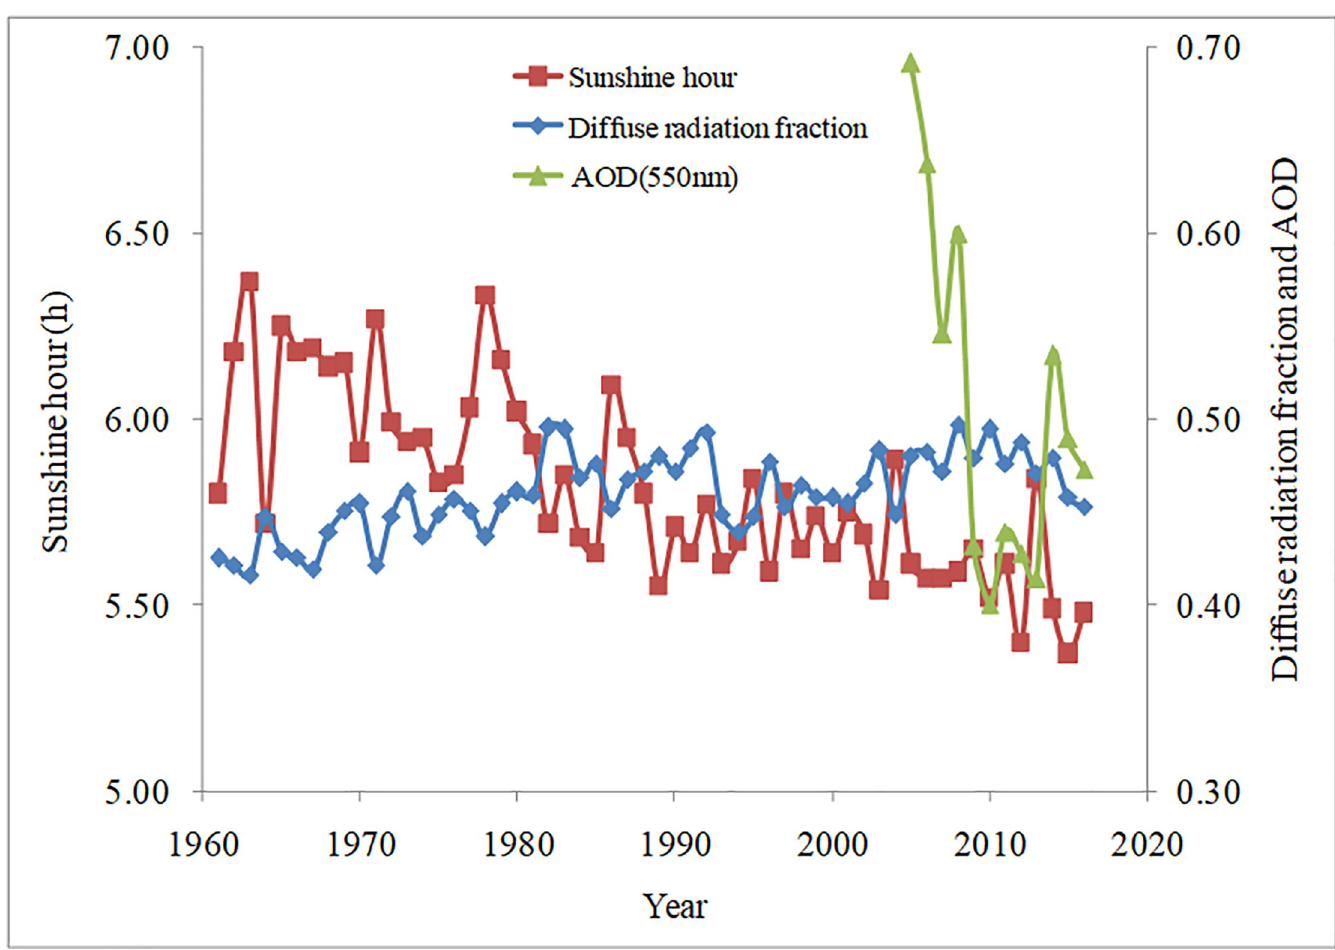
Fig 8. Annual variation of diffuse radiation fraction, sunshine hours, and Aerosol Optical Depth (AOD) from 1961 to